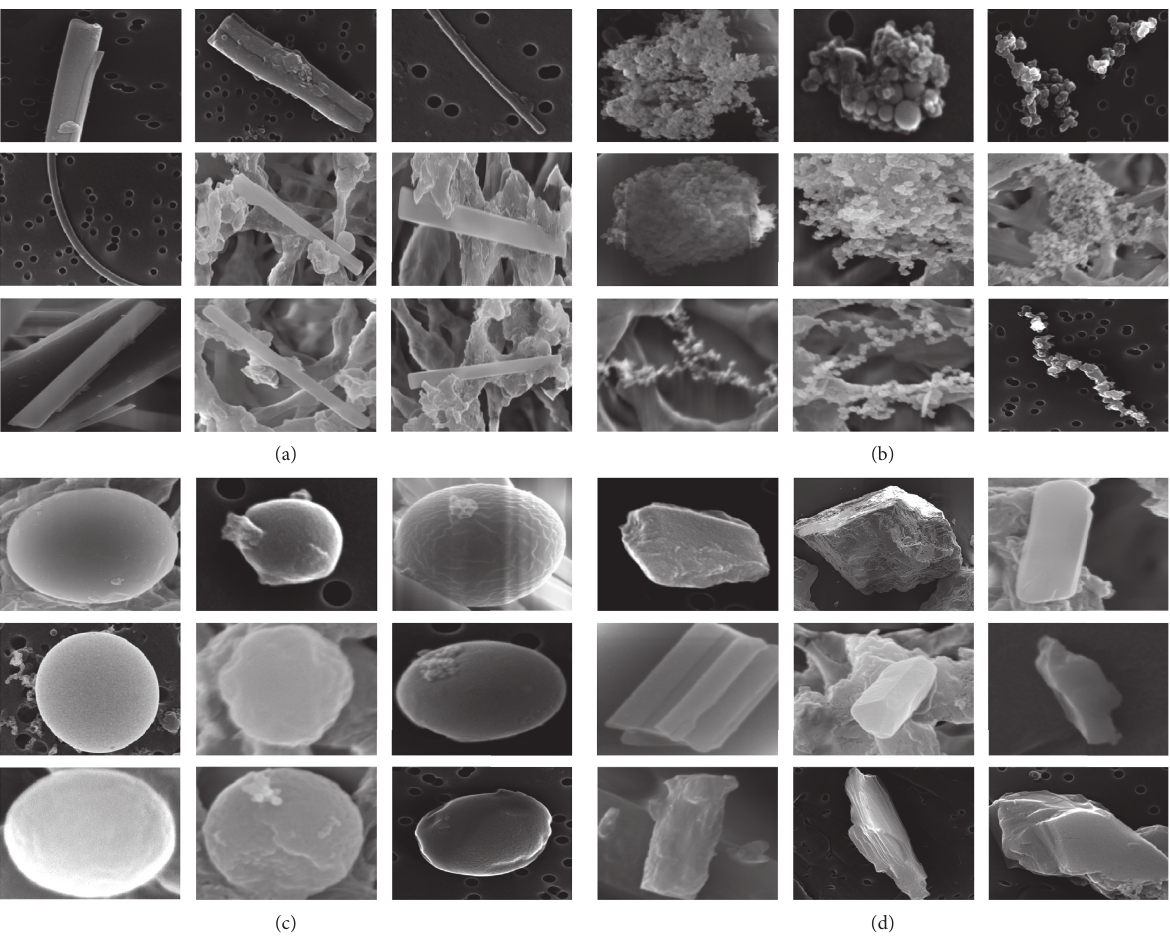
Figure 2: SEM images of the four types of particulates: (a) fibrous particulates; (b) flocculent particles; (c) spherical particulates; (d) mineral